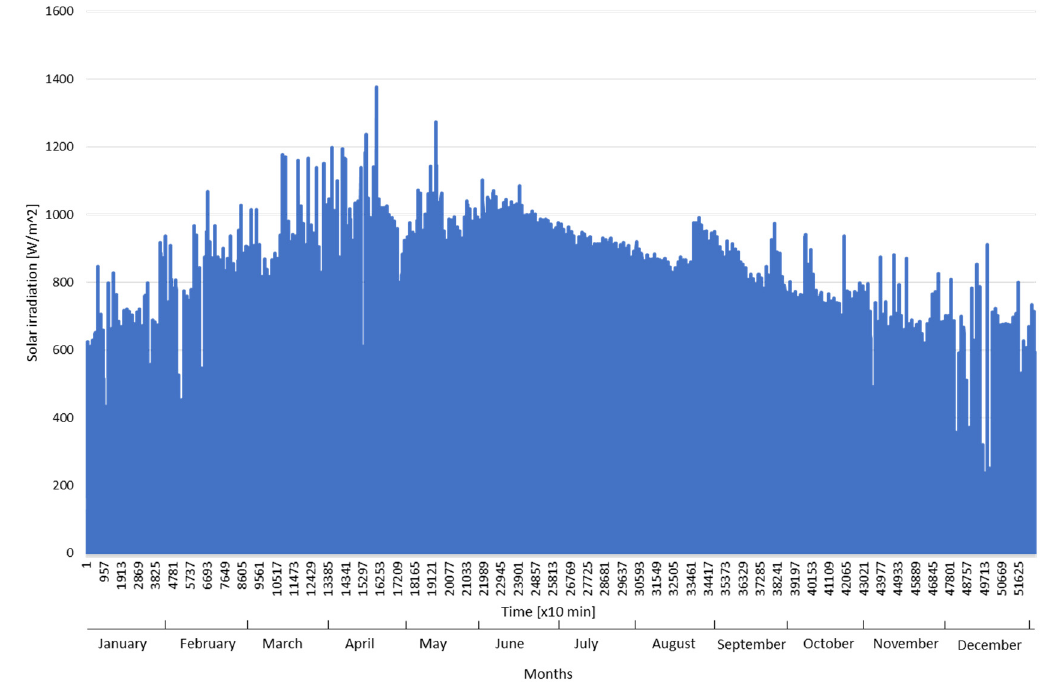
Figure 9. Solar irradiation at 10-min intervals over one year [19,20].